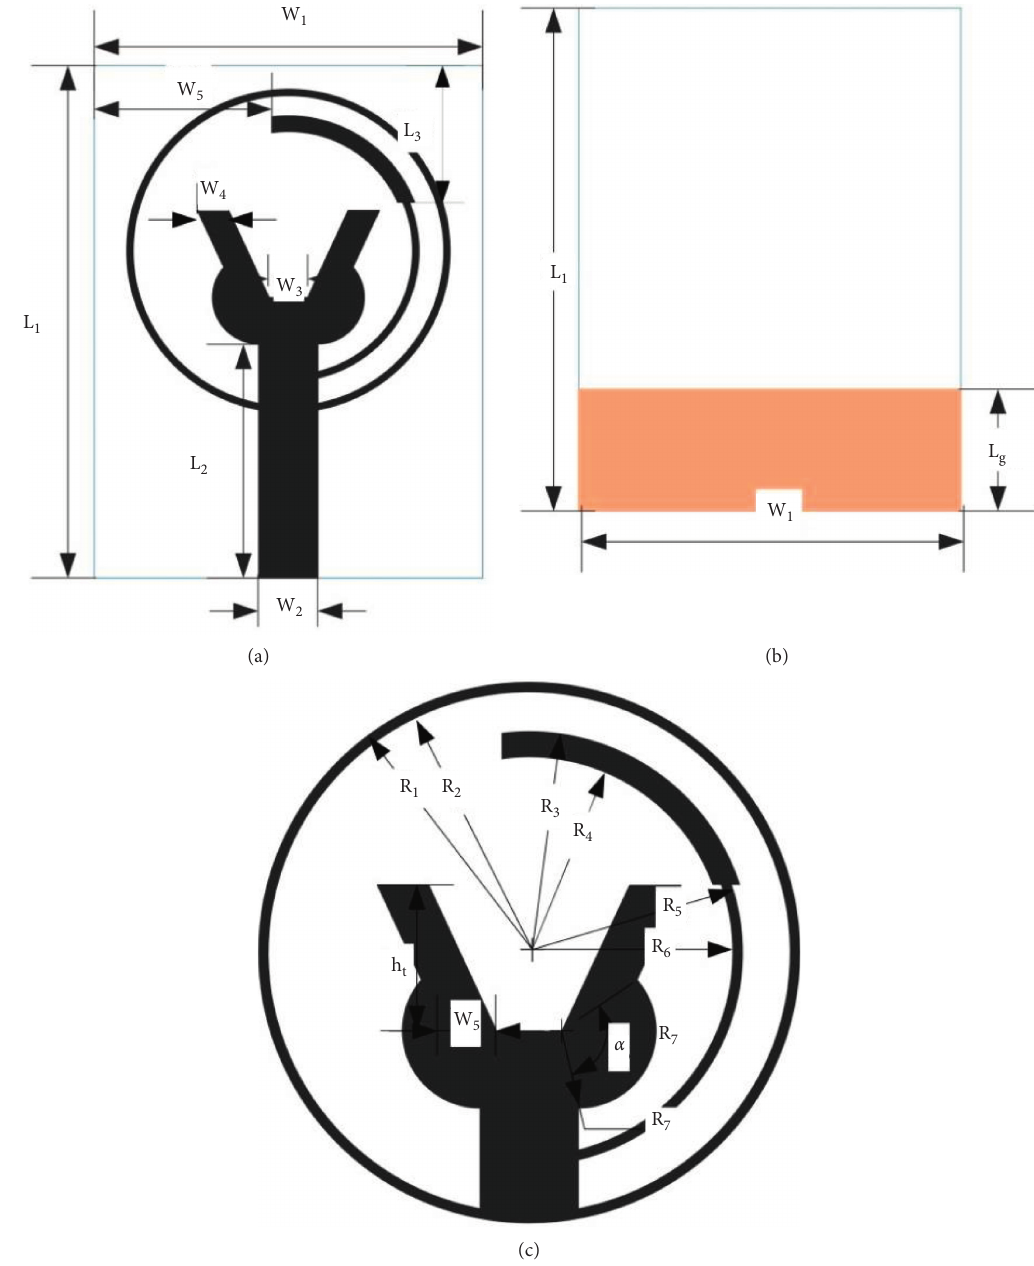
Figure 1: (a) Front view, (b) back view, and (c) radiating element of the proposed